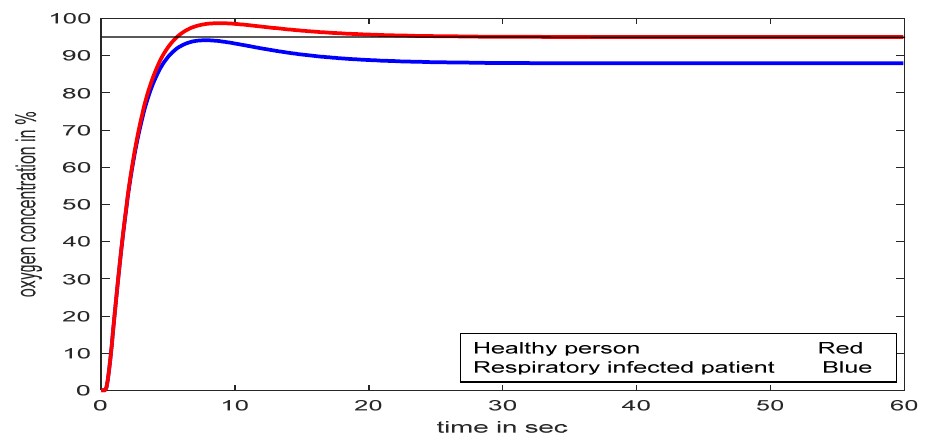
Figure 13. Comparative study of healthy and infected patient with step input at 95%.